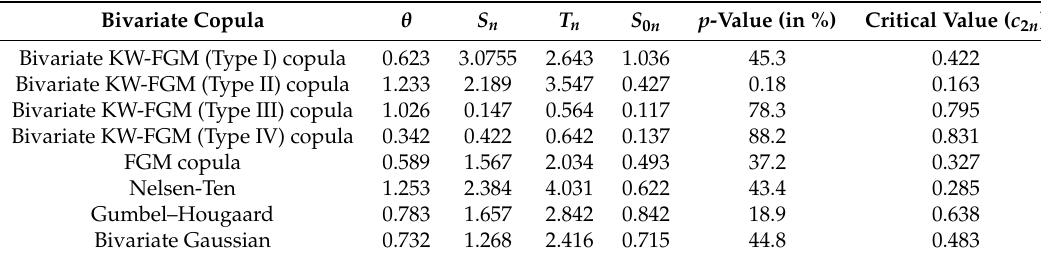
Table 3. Goodness of fit statistics for the insurance